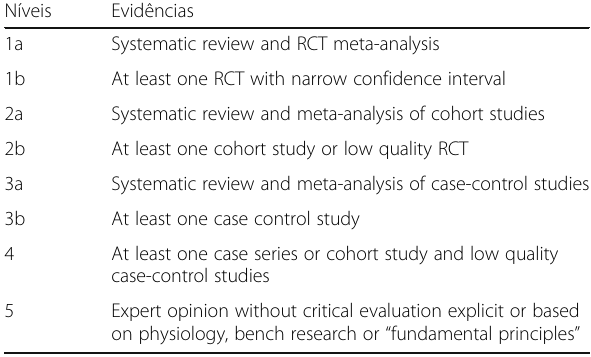
Table 1 Categories of evidence in studies